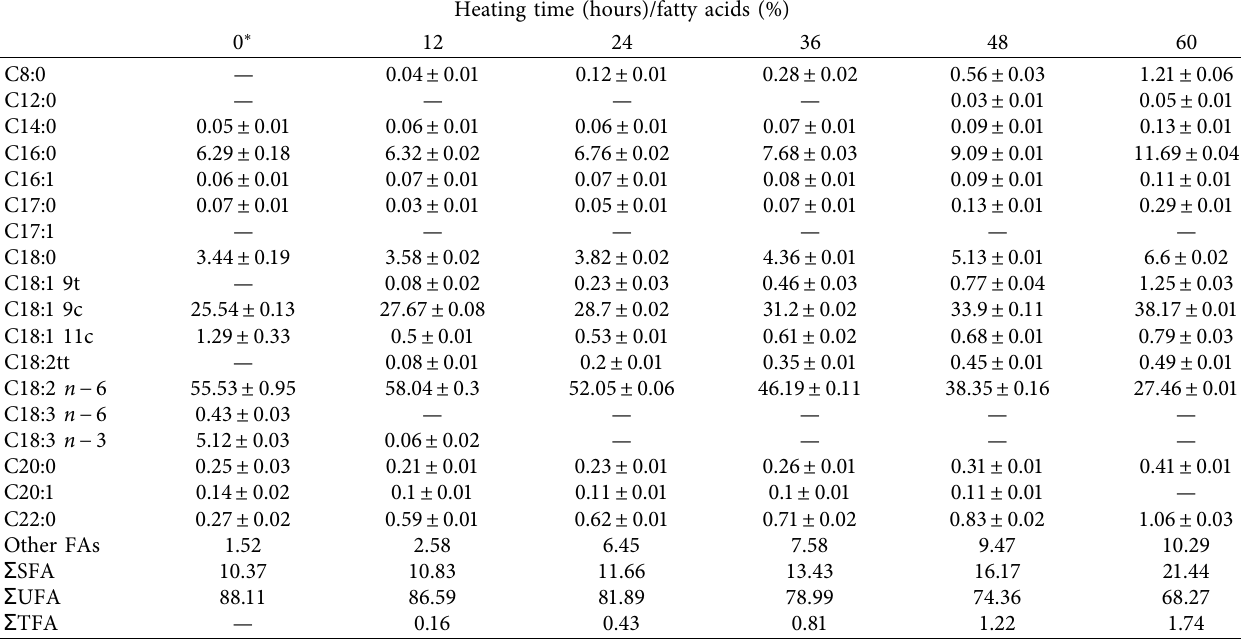
Table 11: Variation of fatty acids of sunflower oil under 240 ° C heating temperature at different heating times. Heating time (hours)/fatty acids (%)